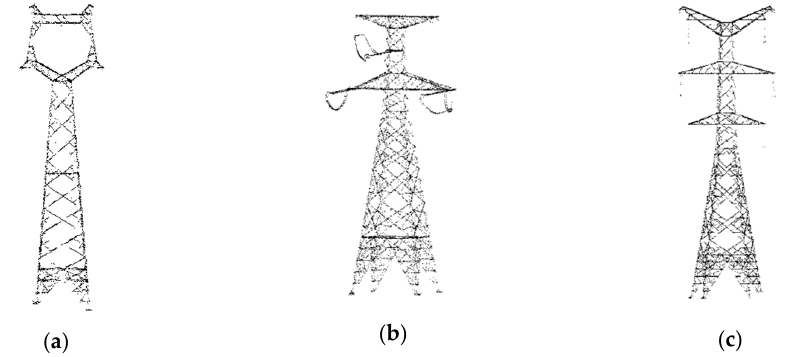
Figure 3. The pylon types of datasets: ( a ) Pylon belongs to the line in Figure 1a; ( b ) pylon belongs to the line in Figure 1c; ( c ) pylon belongs to the line in Figure 1d. Three di ff erent types of pylon are